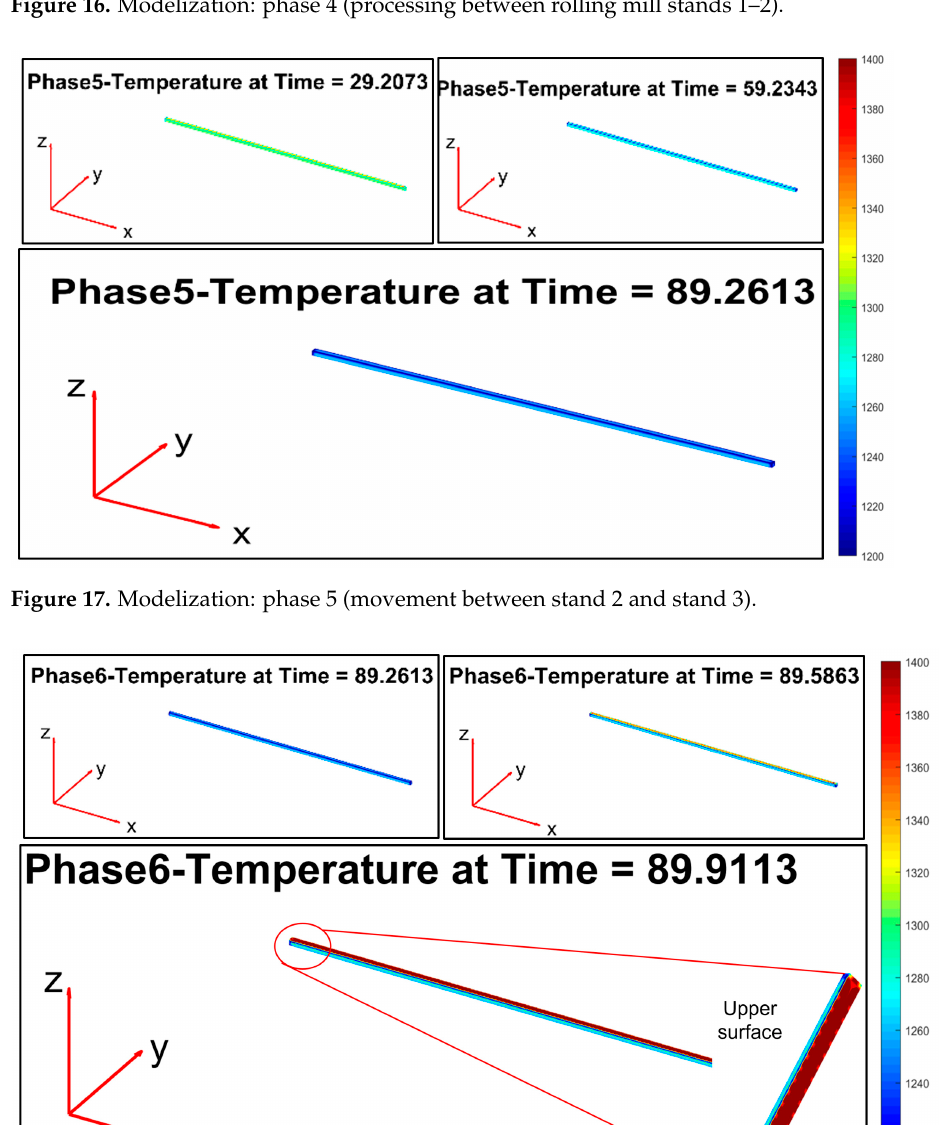
Figure 16. Modelization: phase 4 (processing between rolling mill stands 1–2).